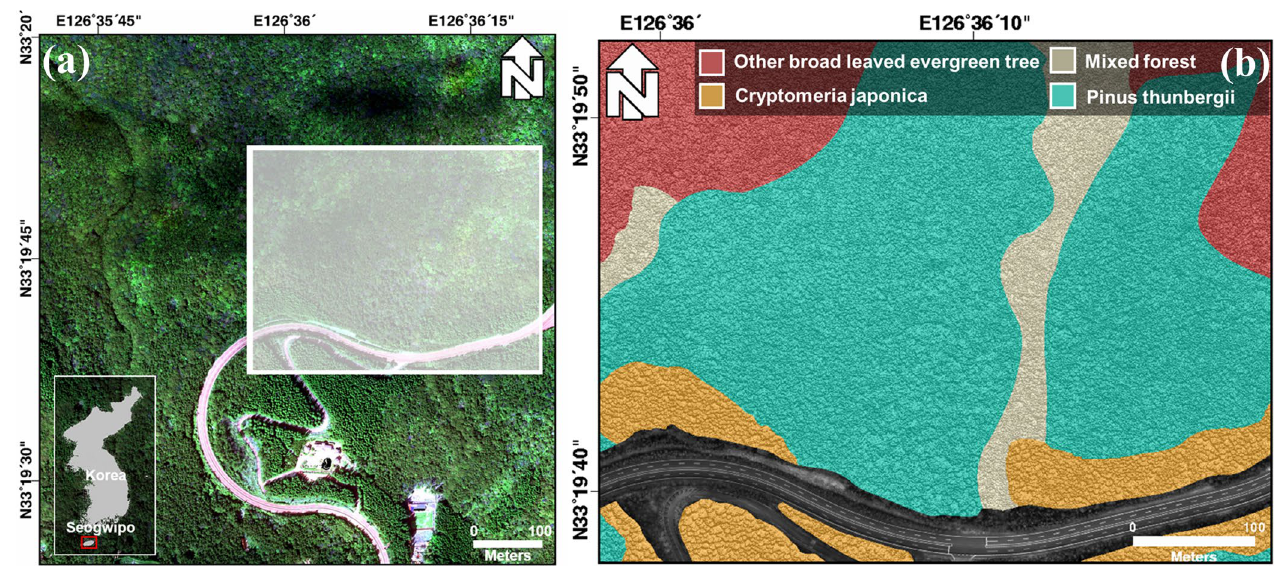
Figure 1. ( a ) Study area; ( b ) tree classification map (ground truth).